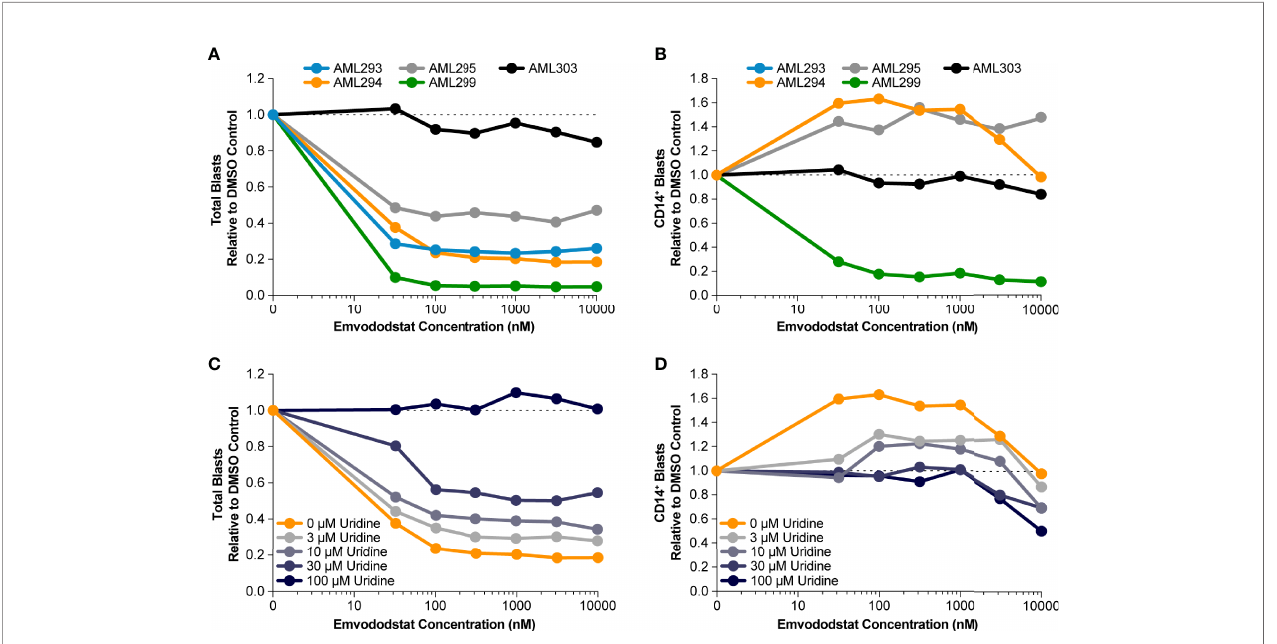
FIGURE 4 | Primary AML blasts cultured ex vivo were treated with increasing concentrations of emvododstat at 37°C for 72 hours. Then samples were stained with appropriate antibodies and evaluated using a fl ow cytometer. Values represent the mean ± SD for triplicate values. Shown is the decrease in the fraction relative to control of (A) total blast cells, (B) CD14+ treated with increasing concentration of emvododstat in primary cell cultures from 5 patients with AML. (C) Using sample AML294, addition of ≥ 30 µM of uridine reversal of the effect of emvododstat on reduction in total blasts. (D) Using sample AML294, addition of ≥ 30 µM of uridine reversed the effect of emvododstat on the increase in CD14+